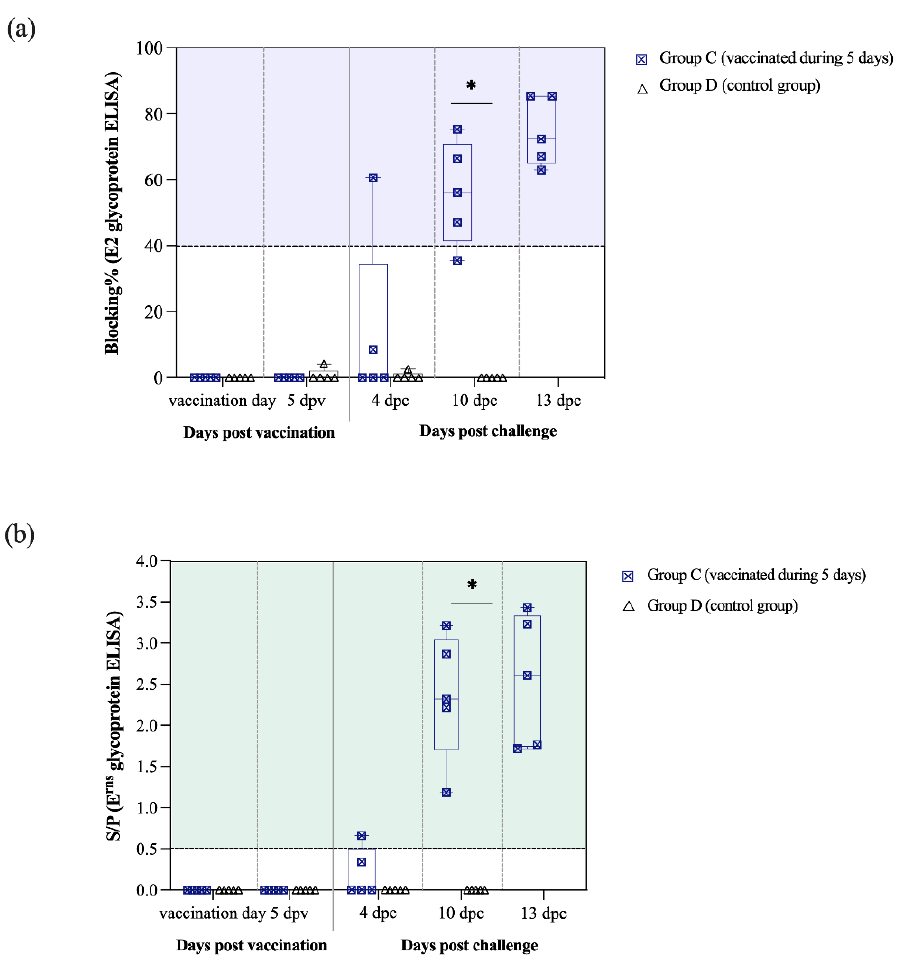
Figure 7. Kinetic of E2 and E rns antibody response in pigs challenged at 5 dpv and controls (groups C and D). ( a ) Antibody response against the E2 glycoprotein was detected by ELISA and is represented as blocking percentage. ( b ) Antibody response against E rns was detected by ELISA and reported as the S/P value in accordance with the formula previously described. Statistically significant differences between the groups C and D in the antibody response against the E2 ( a ) and E rns ( b ) glycoproteins are represented by the asterisk symbol (*), indicating p < 0.05.